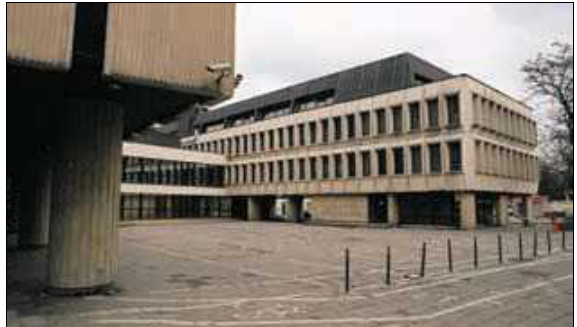
Fig. 19. commu­nication complex in Vilniu­s bu­ilt in